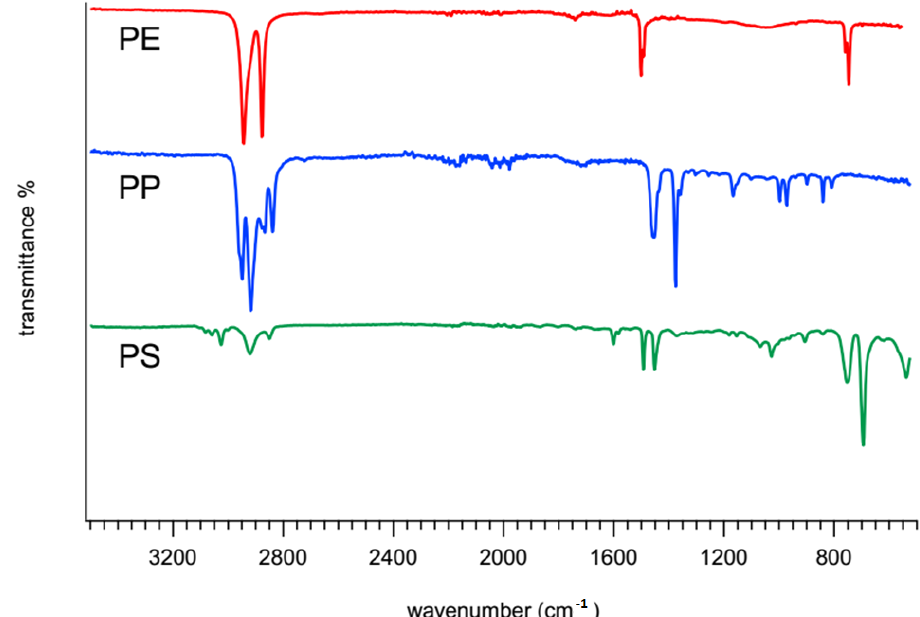
Figure 4. Representative FTIR spectra of most common polymers identified among the analyzed plastic debris: PE (red curve), PP (blue curve) and PS (green curve).